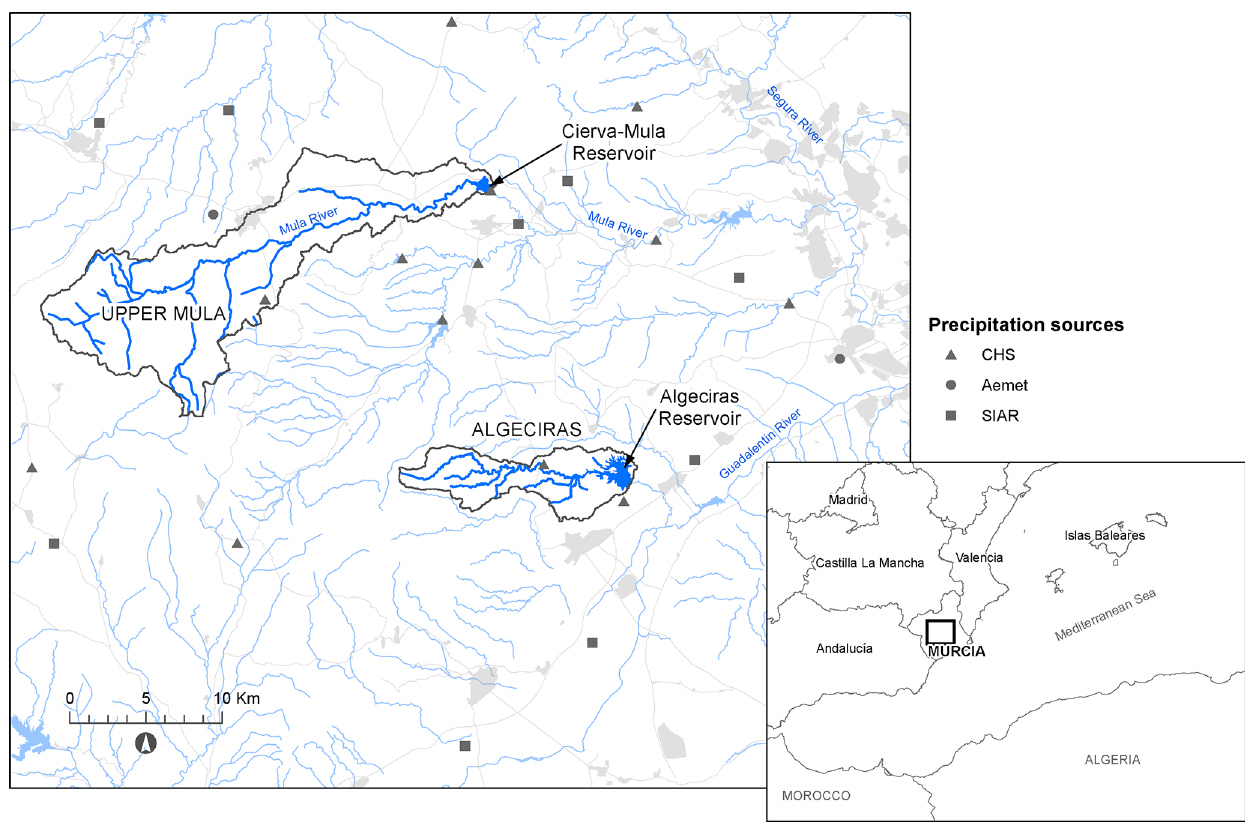
Figure 1. Location of the watersheds and precipitation gauges.